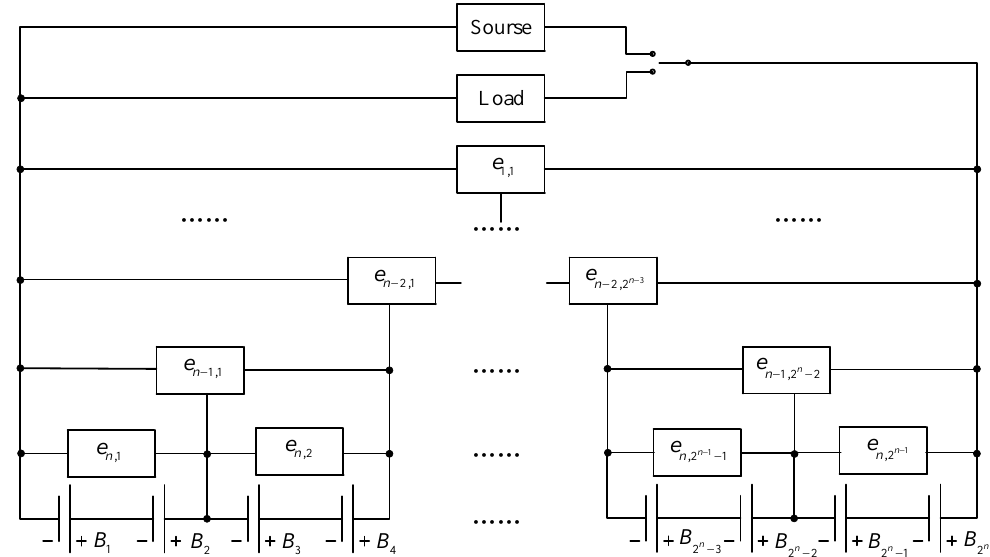
Figure 1. Schematic diagram of equalization system composed of 2 n single cells.